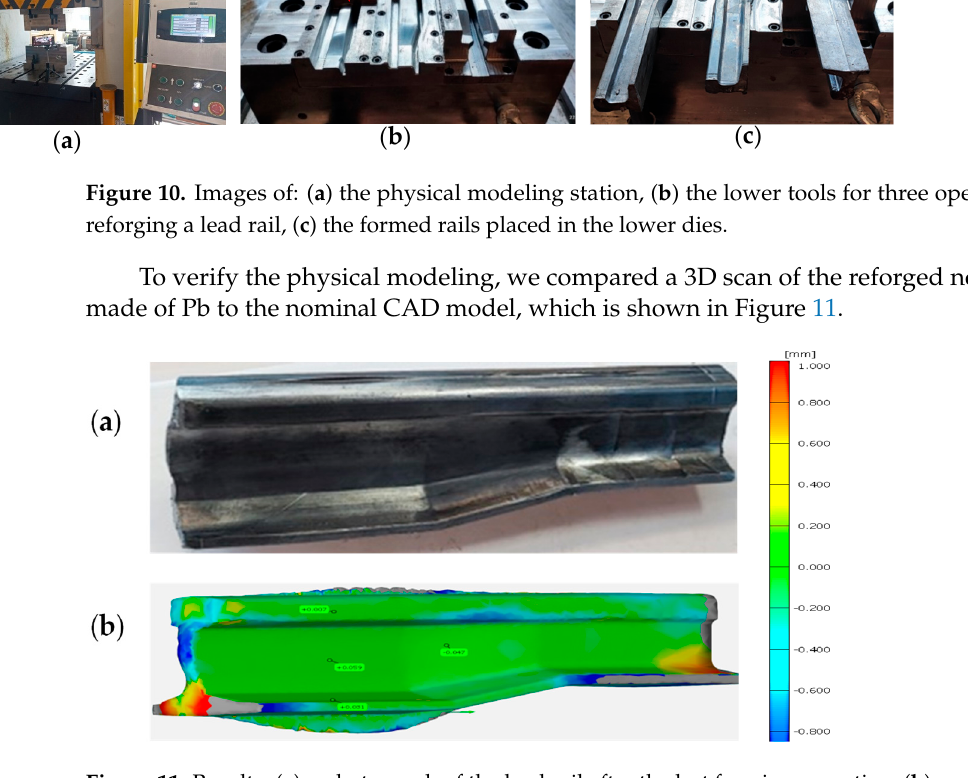
Figure 11. Results: ( a ) a photograph of the lead rail after the last forming operation, ( b ) a comparison of the shape and dimensions from FEM with the experiment, with a map of deviations (green color is best fit).